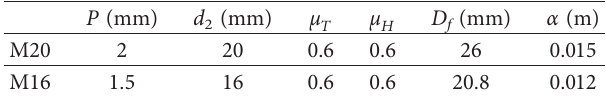
Figure 21: Torque-deformation curve of a combination of 8 disk springs. Table 4: Parameter of tie-bolt M20 and M16 to determine the torque-pretension